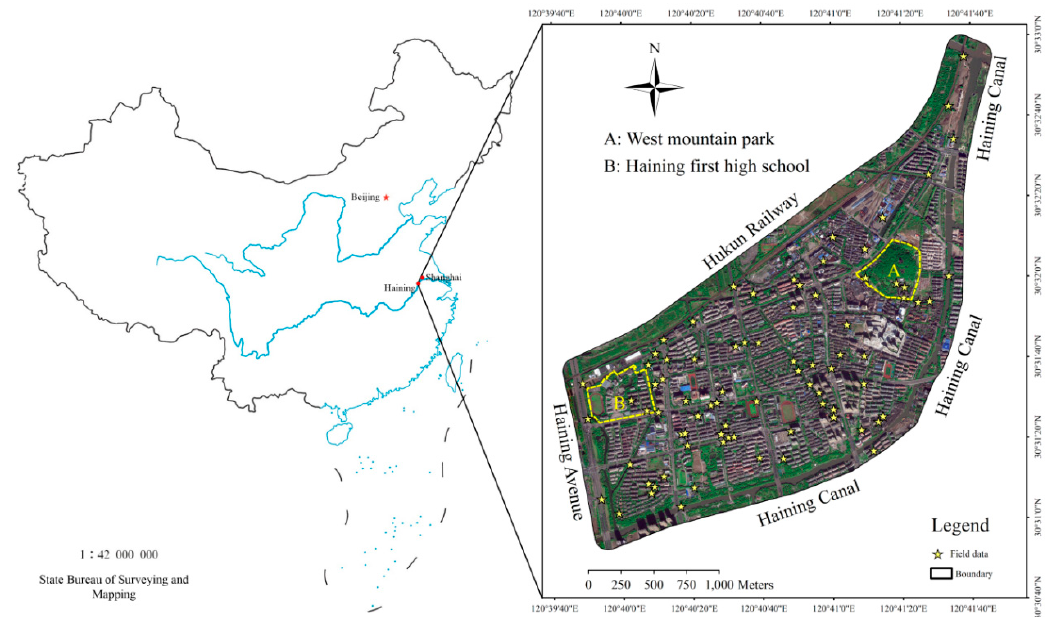
Figure 4. Study area.